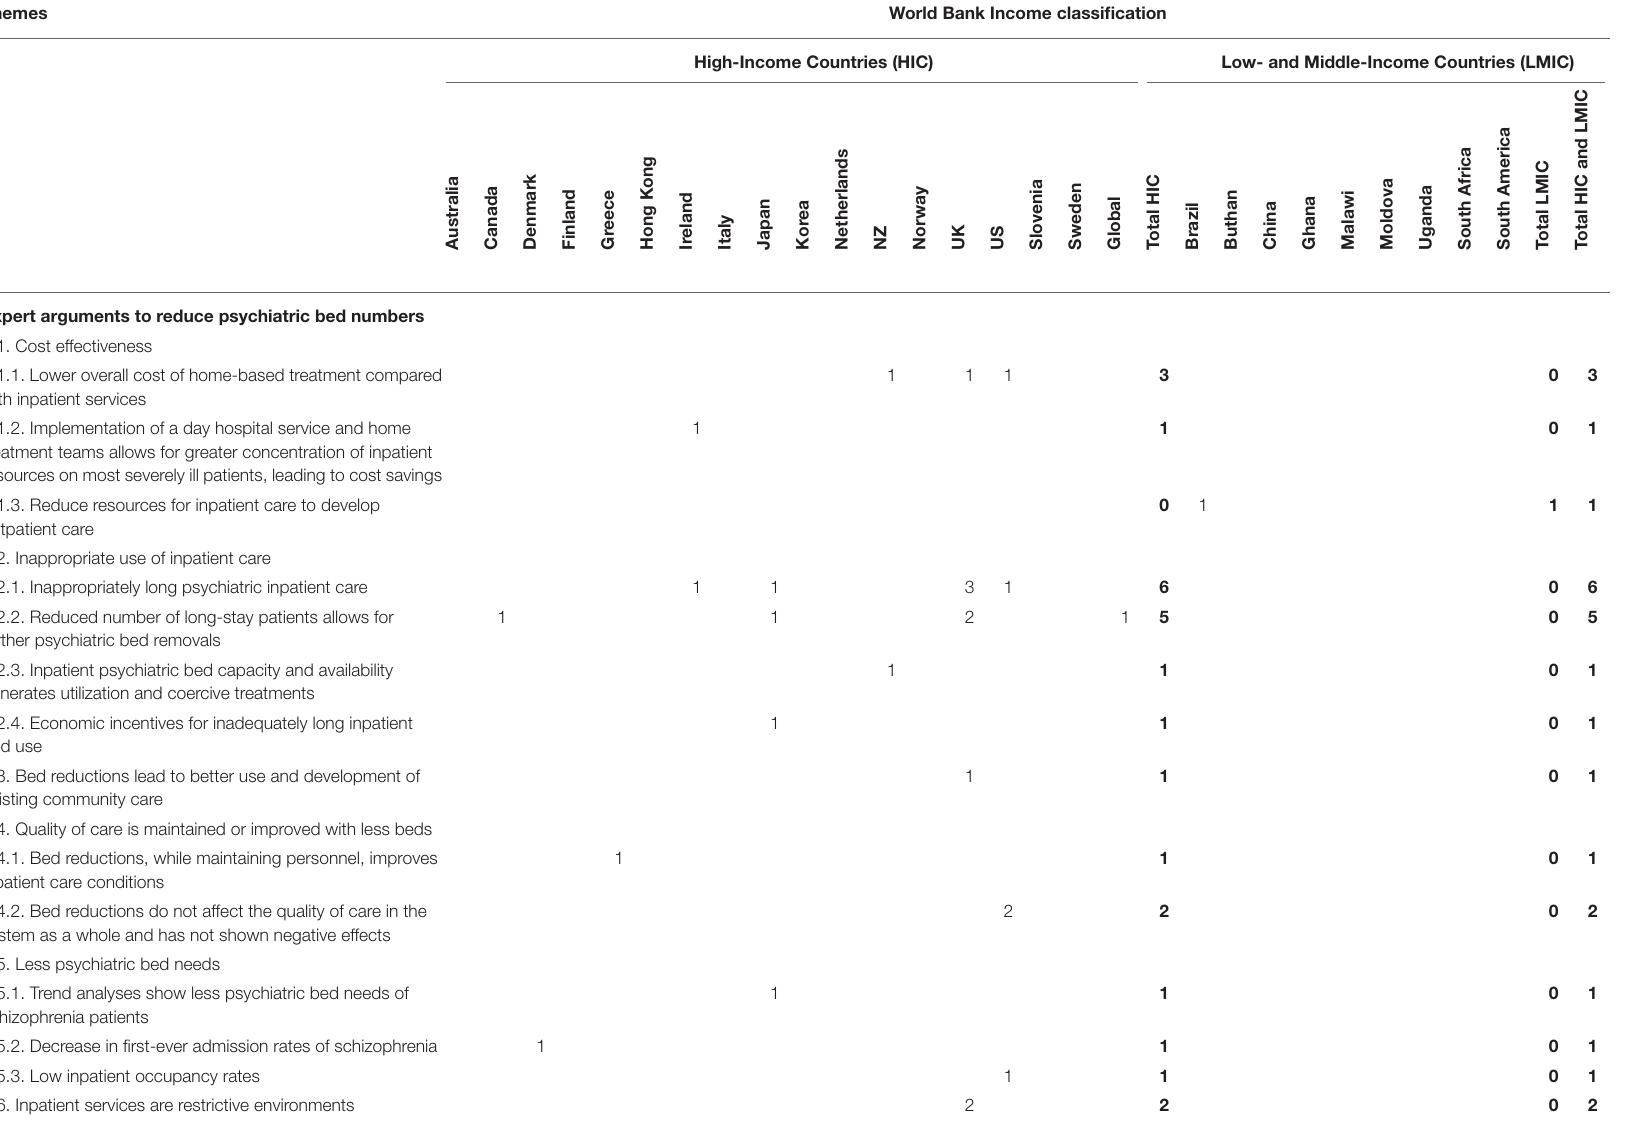
TABLE 2 | Number of expert arguments per theme and country.